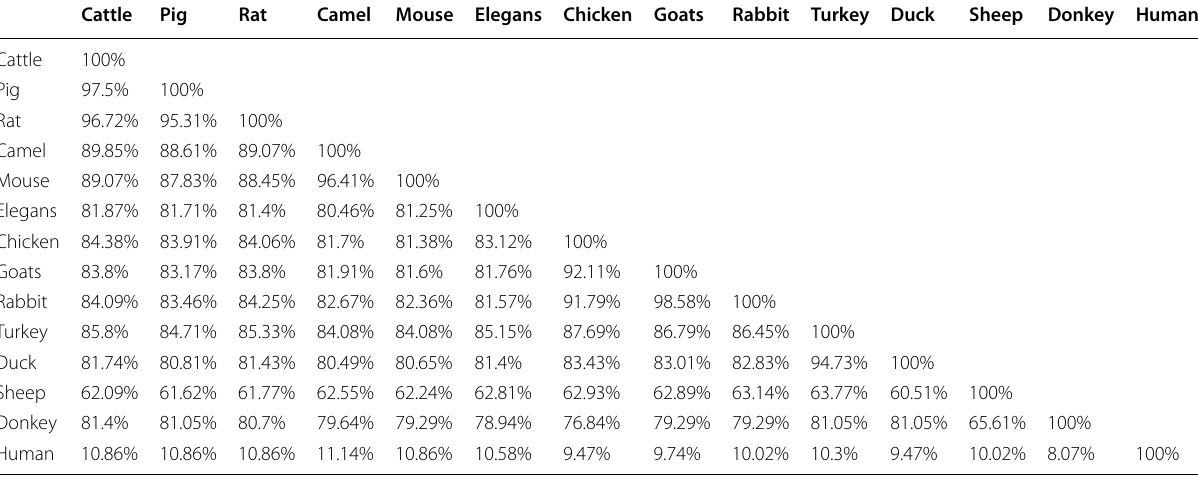
Table 1 Comparative percentages of exact character match among the aligned HSP70 amino acid sequences of the selected animals Cattle Pig